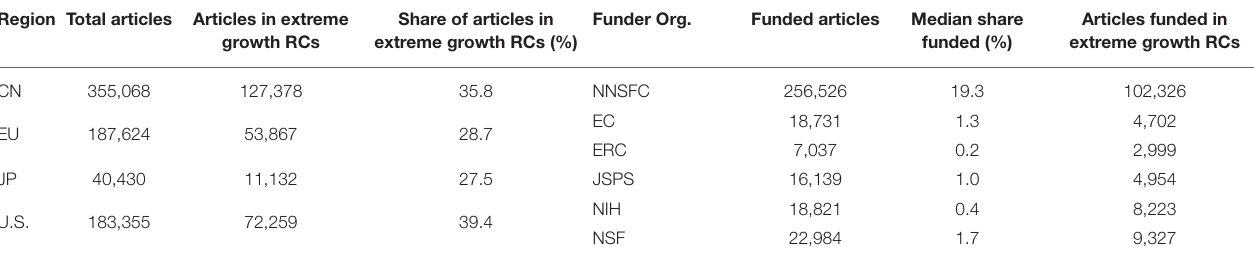
TABLE 4 | Publications in AI research clusters: production by region, funding organization, and presence in extreme growth RCs. Region Total articles Articles in extreme Share of articles in Funder Org. growth RCs extreme growth RCs (%)